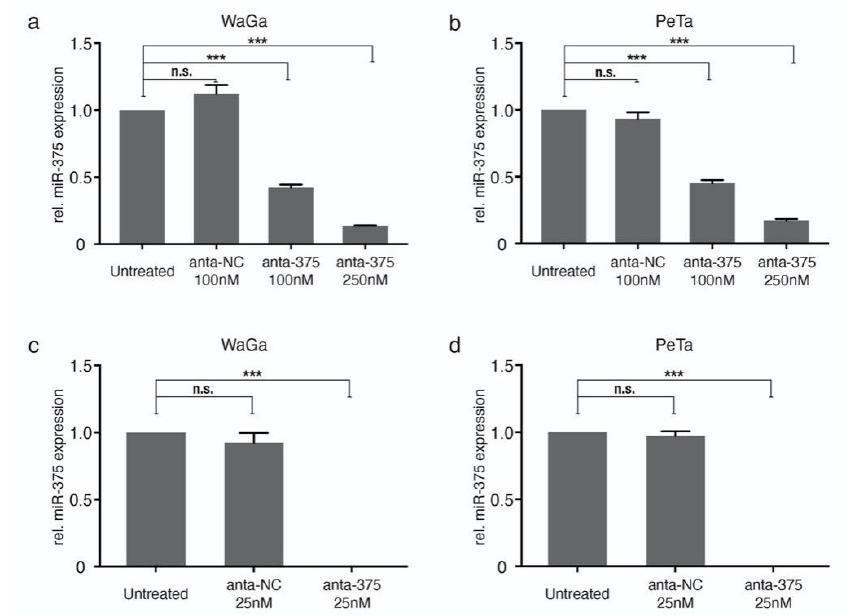
Figure 1. Knockdown of miR-375 in classical Merkel cell carcinoma (MCC) cell lines. Relative miR-375 expression was determined in triplicate by qRT-PCR in WaGa ( a , c ) and PeTa ( b , d ) cells transfected with miR-375 antagomiRs (anta-375) or a negative control (anta-NC) using lipofectamine (top row; a , b ) or nucleofection (bottom row; c , d ). Quantification cycle threshold (Cq) values were normalized to the small nucleolar RNA RNU6B (U6) and calibrated to the untreated WaGa cells. All experiments were independently repeated three times. Error bars represent SD, *** indicates p < 0.001. n.s.: non- significant.